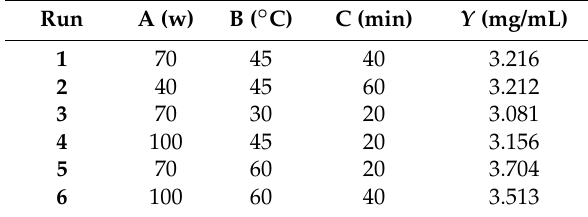
Table 1. Box–Behnken designs for tea-leaf saponins ultrasonic-assisted water extraction.